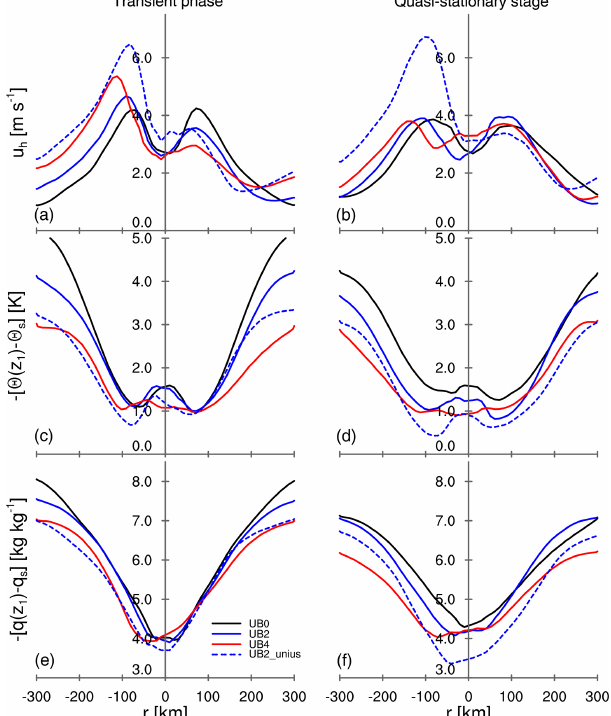
Figure 4. As in Fig. 3 but for (a, b) the near-surface horizontal wind u h , (c, d) the vertical difference of potential temperature − (cid:2) θ(z 1 ) − θ s (cid:3) , and (e, f) the vertical difference of humidity − (cid:2) q(z 1 ) − q s (cid:3) . The subscript s denotes the property at the surface, and z 1 represents the first model level above the surface, which is at 37 . 5m in our